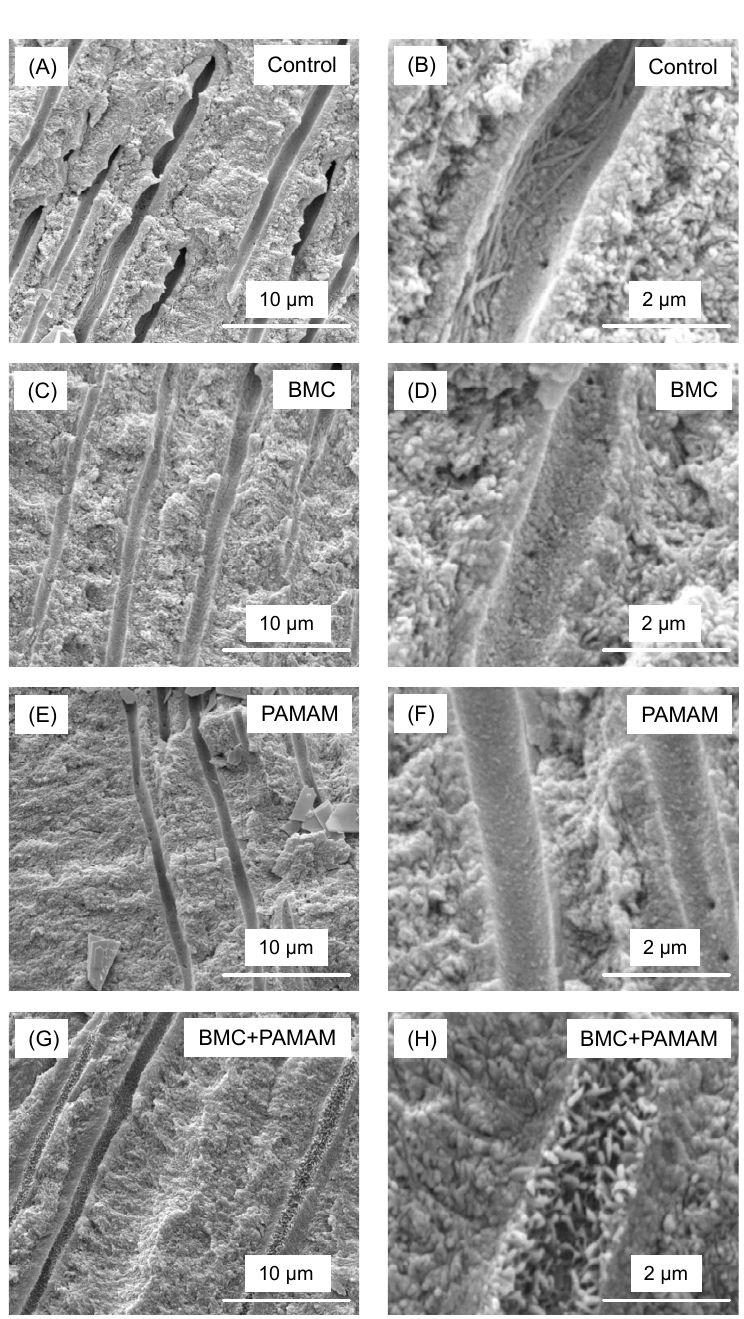
Figure 6. Representative scanning electron microscopy (SEM) images of demineralized root dentin subsurface cross-section parallel to tubule axis after 21 days cyclic artificial saliva/lactic acid regimen: ( A , B ) control; ( C , D ) BMC group; ( E , F ) PAMAM group; and ( G , H ) BMC + PAMAM. Left column is a lower magnification. Right column is a higher magnification. Exposed collagen fibrils were detected in ( A , B ). ( C – F ) show that minerals precipitated in tubules. In ( G , H ), the dentinal tubules were occluded by a great amount of the remineralized minerals.